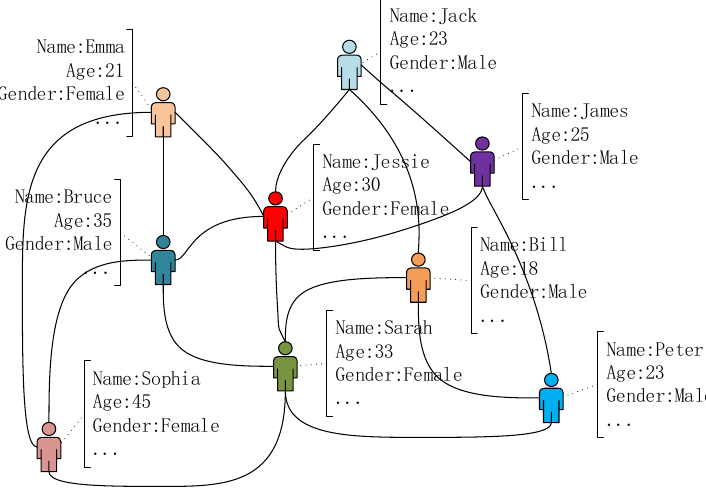
Figure 1. A social network with users as nodes. Texts next to the nodes are the profiles of the users, which can be regarded as node